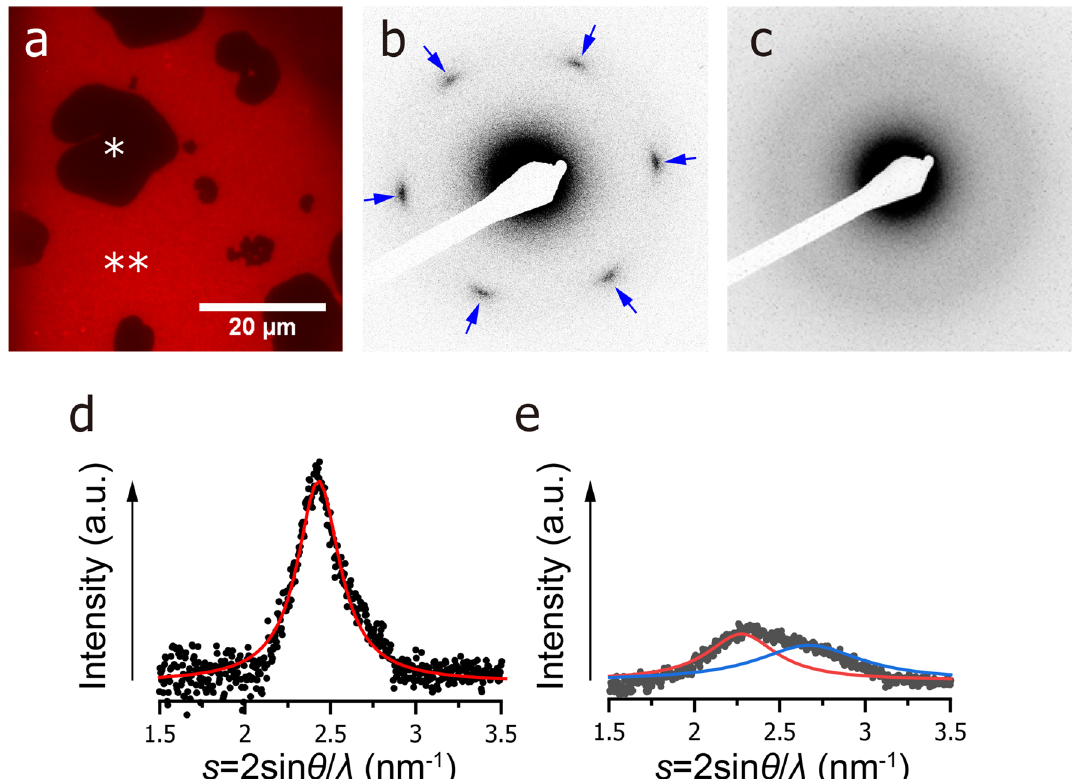
Figure 5. Selective acquisition of ED patterns from the ordered and disordered domains. ( a ) A fluorescent micrograph of the DSPC/DOPC ( x DSPC = 0.3) monolayer formed on a collodion-coated TEM-grid. Since sample contain 0.2 mol% Texas Red-DPPE, a disordered domain marker, the (*) darker and (**) brighter regions correspond to the ordered and disordered domains, respectively. ( b ) and ( c ) show ED patterns obtained in the ordered and disordered domains, respectively. Arrows indicate the hexagonal spot obtained in the ordered domain. The selected area is 0.79 μm 2 , corresponding to a diameter of 1 μm. An exposure time of five seconds was used. ( d ) and ( e ) show the one-dimensional ED profiles of ( b ) and ( c ), respectively. Although we subtracted the background using a monolayer-free TEM-grid (see “Materials and methods” for details), the diffraction peak from the collodion film could not be completely removed in the panel ( e ). This is because the thickness of the collodion film is not homogeneous on the TEM-grid. Thus, we deconvoluted those peaks using the two Lorentz functions; the red and blue profiles show the diffraction peaks corresponding to the carbon chains and the collodion film,